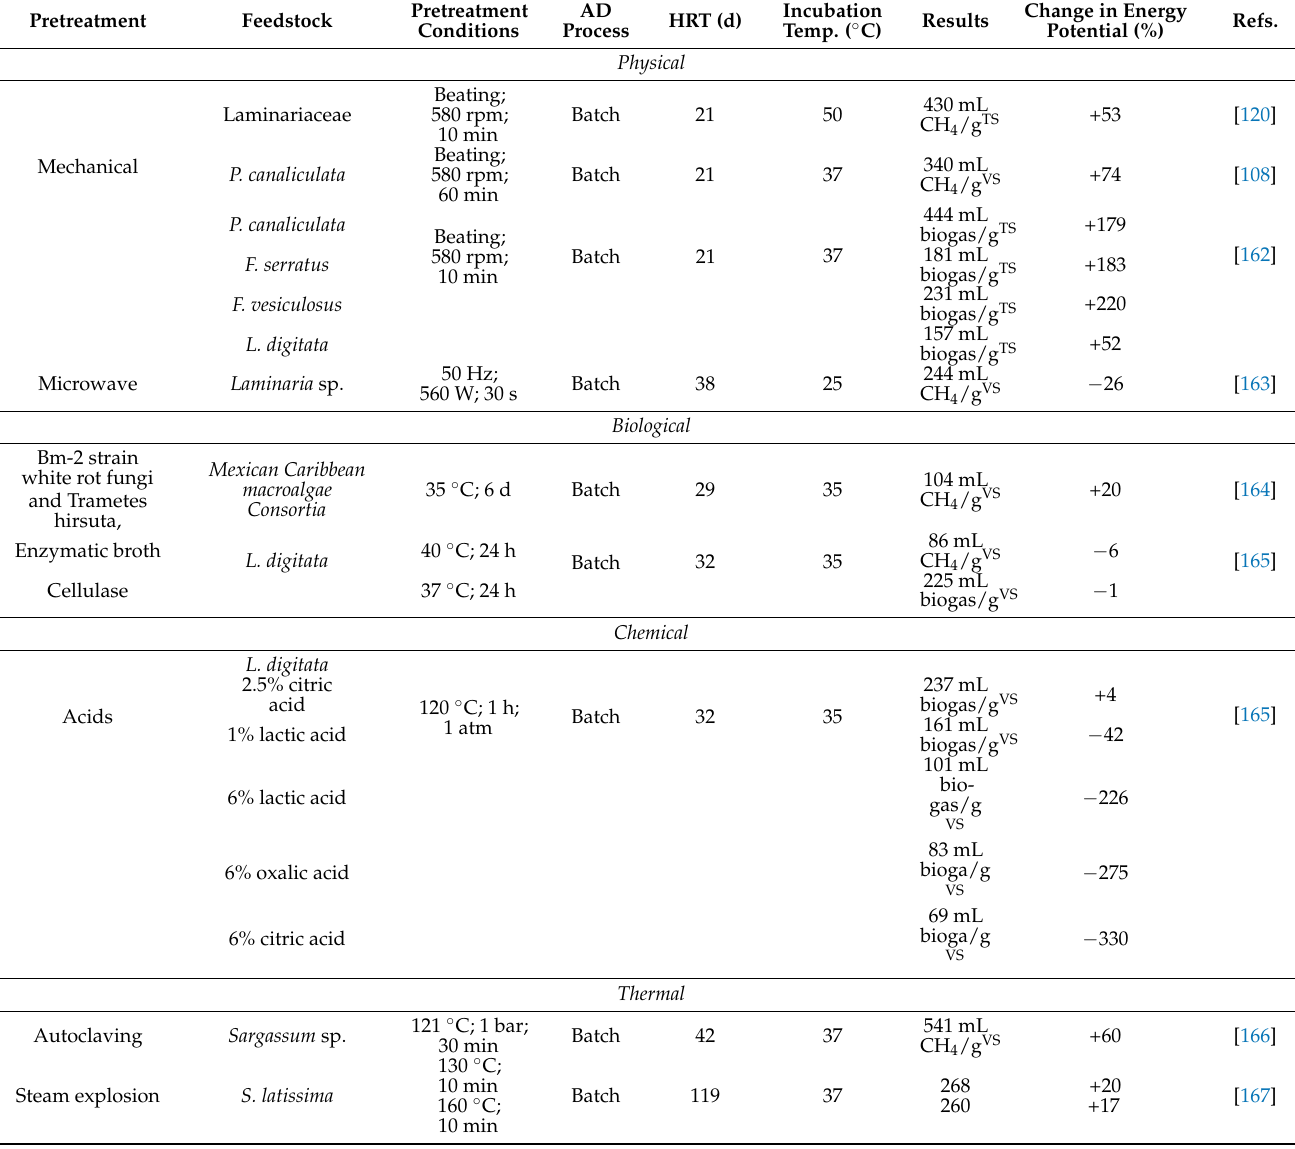
Table 6. Biogas/biomethane enhancement of seaweed by various